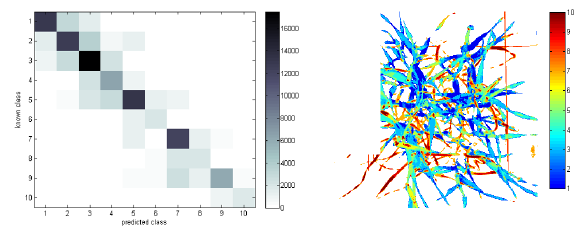
Figure 9: Confusion matrix and predicted labels by the Linear Ordinal SVM for a hyperspectral image of a barley plants